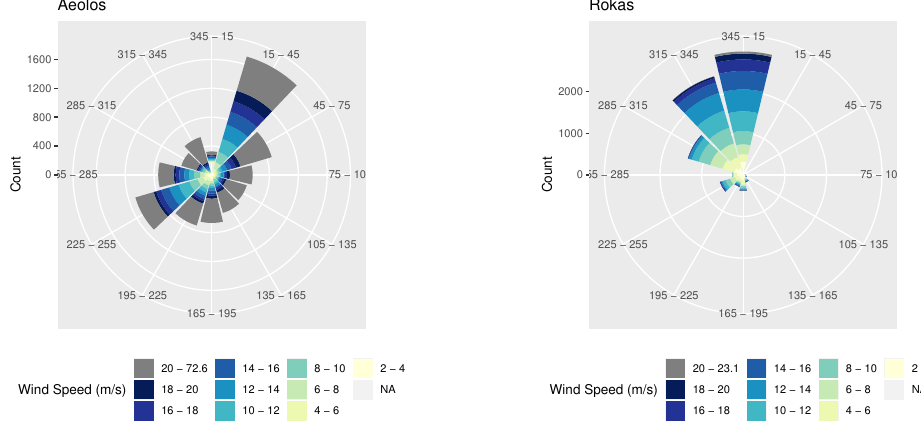
Figure 3. Wind roses providing a view of how wind speed and direction are distributed at the Aeolos ( left ) and Rokas ( right ) wind farms.